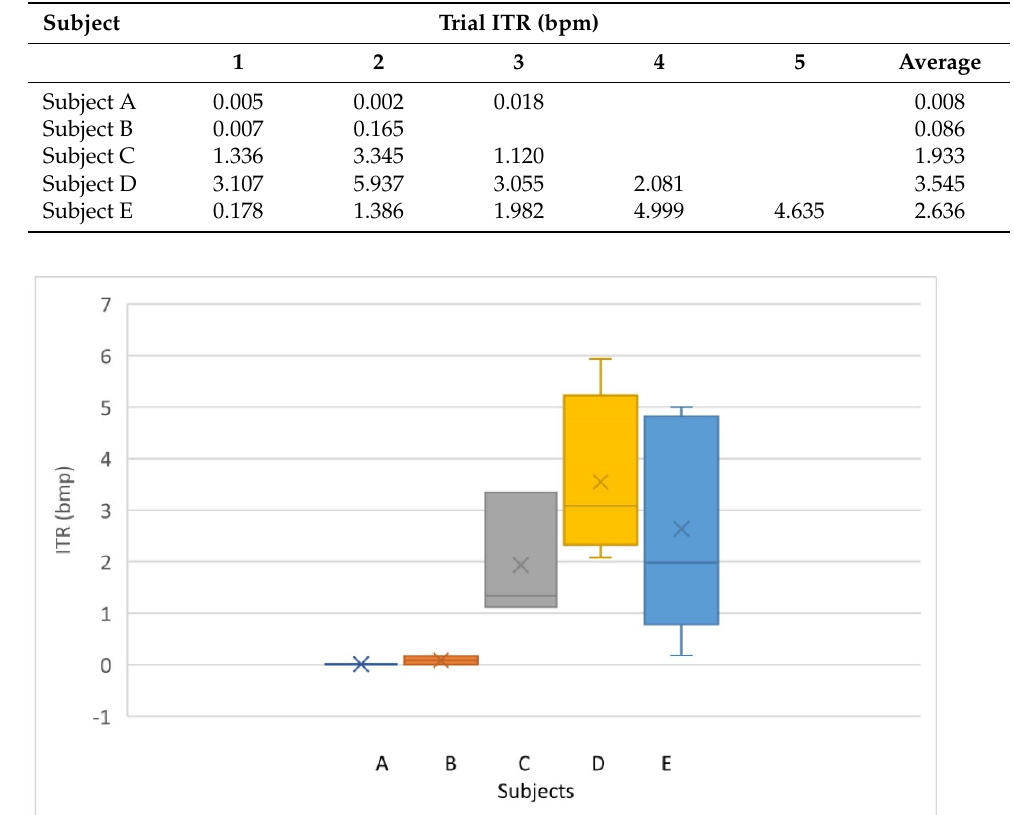
Figure 20. Distribution and average ITR of each subject.